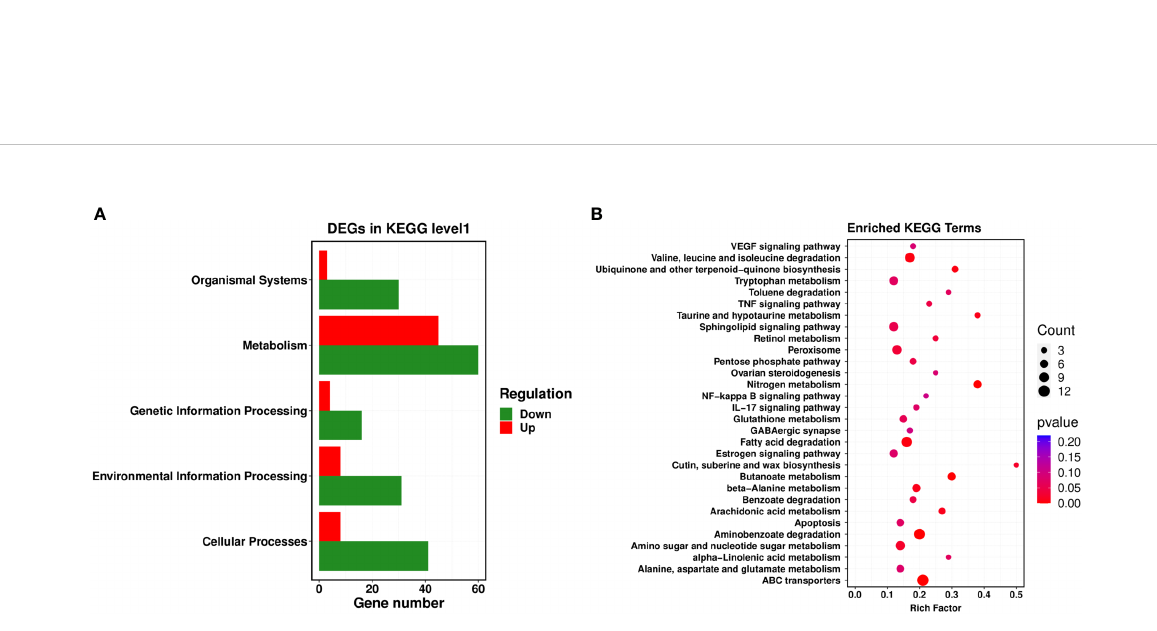
FIGURE 3 KEGG enrichment analysis of PCN-related DEGs. (A) level 1 metabolic pathways; (B) level 2 metabolic